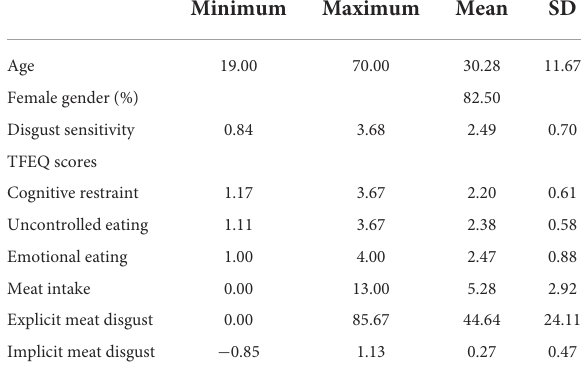
TABLE 1 Sample characteristics at